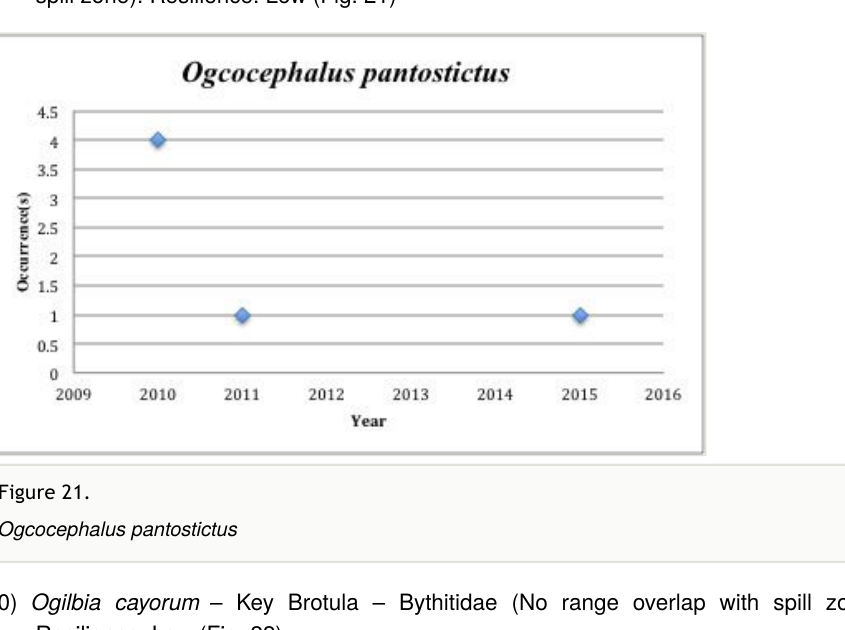
Resilience: Low (Fig. 22)